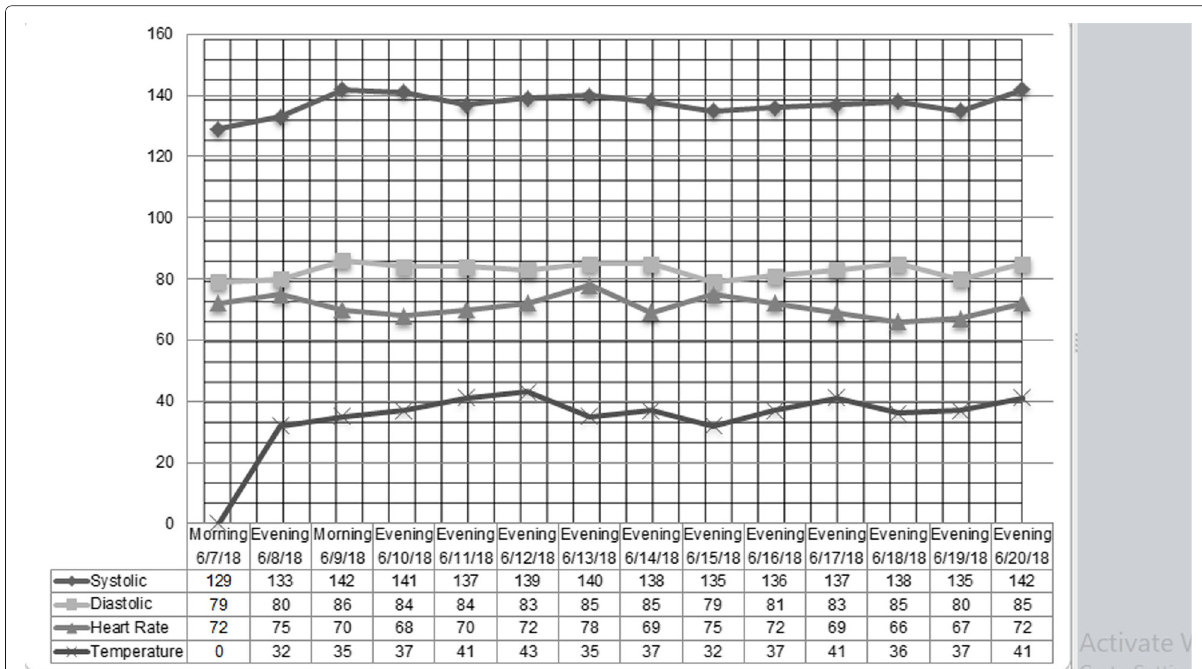
Fig. 7 The WISE data